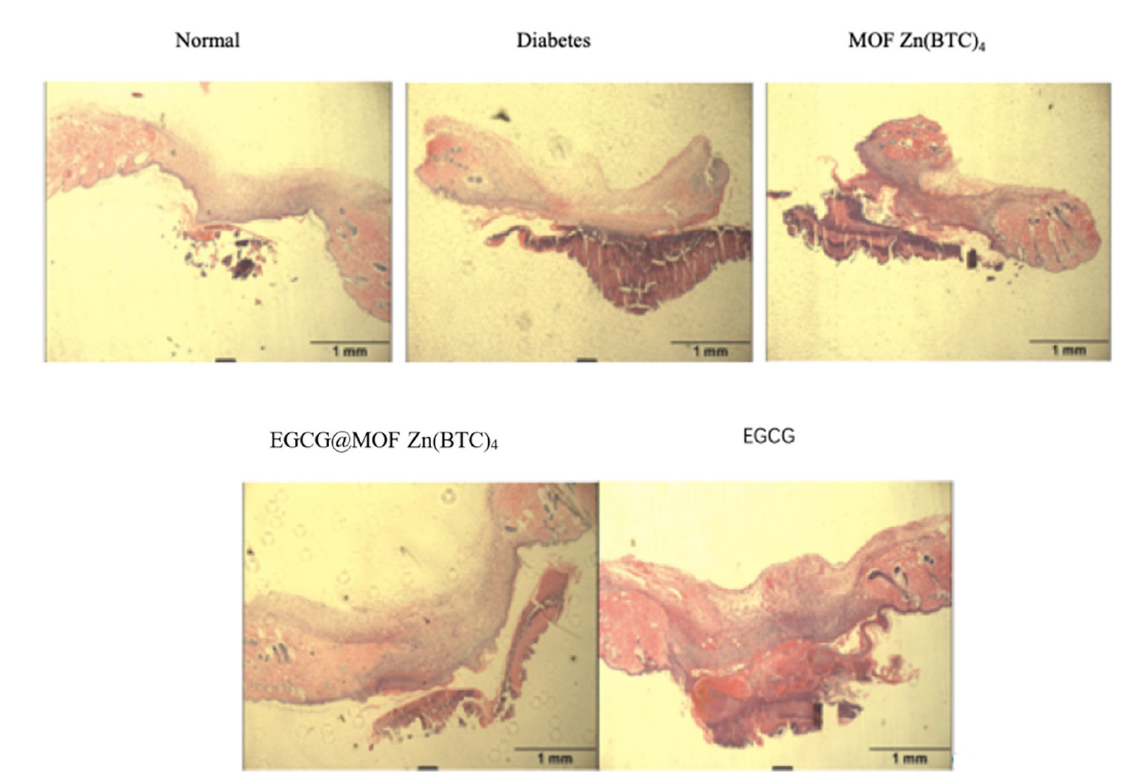
Figure 10. Tissue morphology in skin